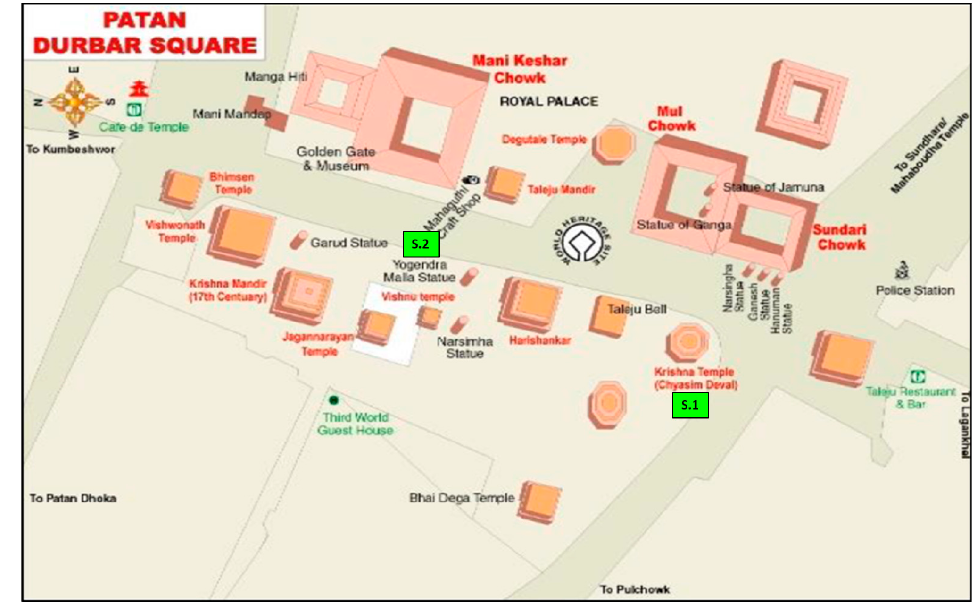
Figure A2. Layout of the Patan Durbar square [2]. Location of monuments sampled indicated.